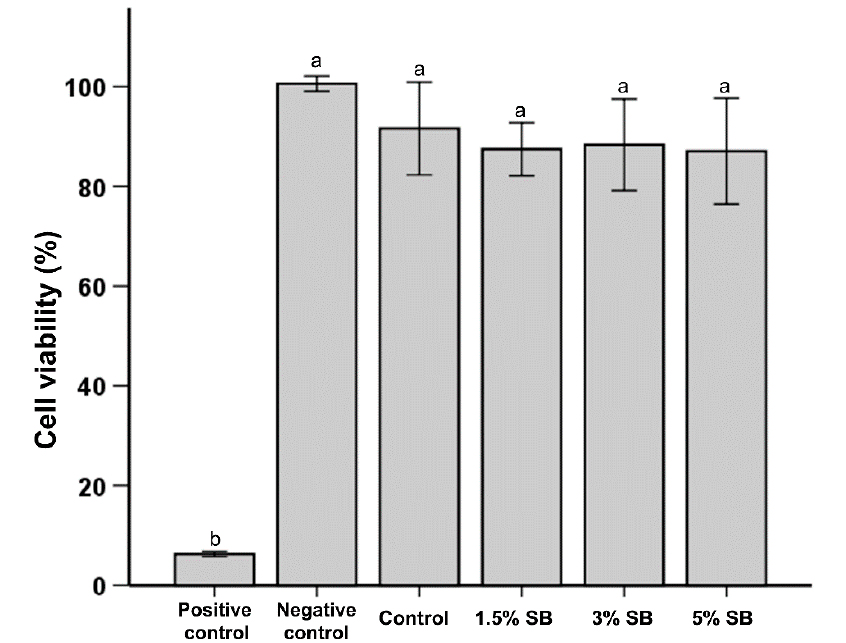
Figure 4. Comparison of the L929 cell viability among control samples and samples with different percentages of SB. The same lowercase alphabetical letters above the bar graph indicate there are no significant differences between the groups.